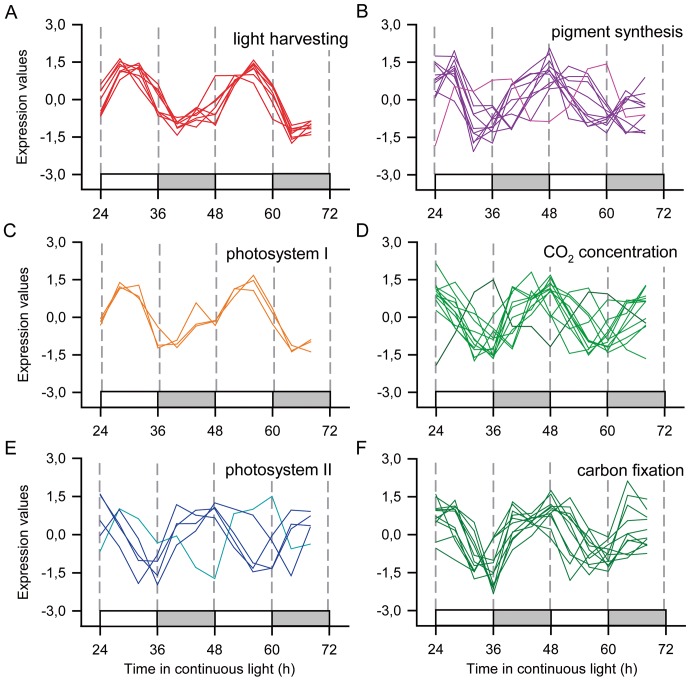
Rhythmic probes associated with the photosynthetic pathways.Z-score normalized time courses of rhythmic probes for transcripts associated with the photosynthetic pathway were separated into (A) light harvesting complex (red); (B) chlorophyll, carotenoid and xanthophyll synthesis (purple); (C) photosystem I (orange); (D) CO2 concentration mechanisms (light); (E) photosystem II (blue); and (F) carbon fixation mechanisms (dark green). Lines in different colours indicate probes with contrasting phases. White boxes represent periods of subjective day and light grey boxes represent periods of subjective night.